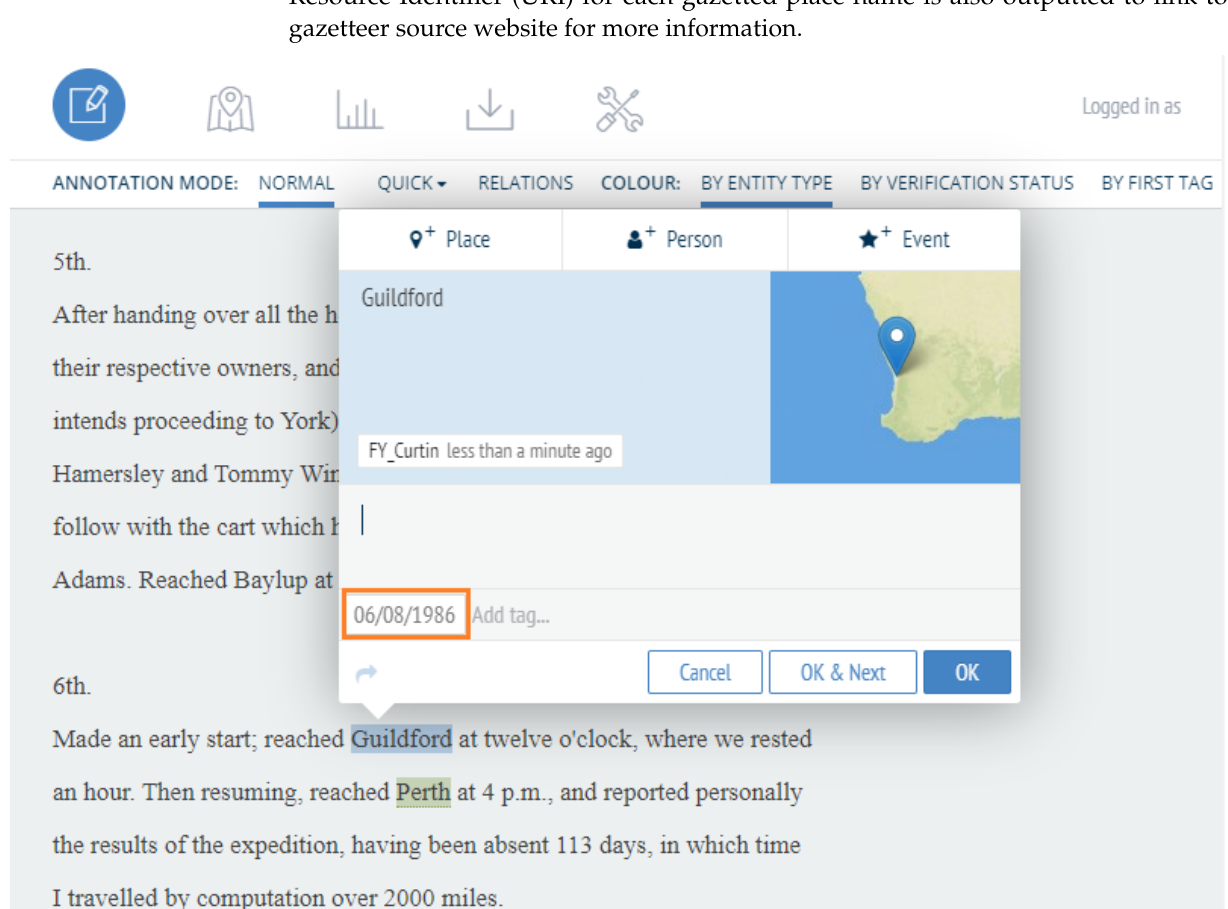
Figure 3. Annotating place names in Recogito/TMT.